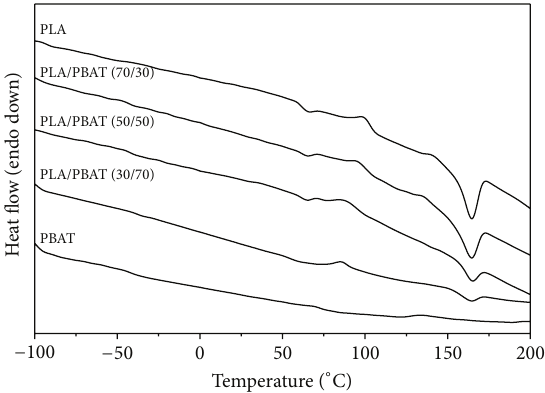
Figure 2: Melt-quenched scanning DSC thermogram of PLA/PBAT blends.